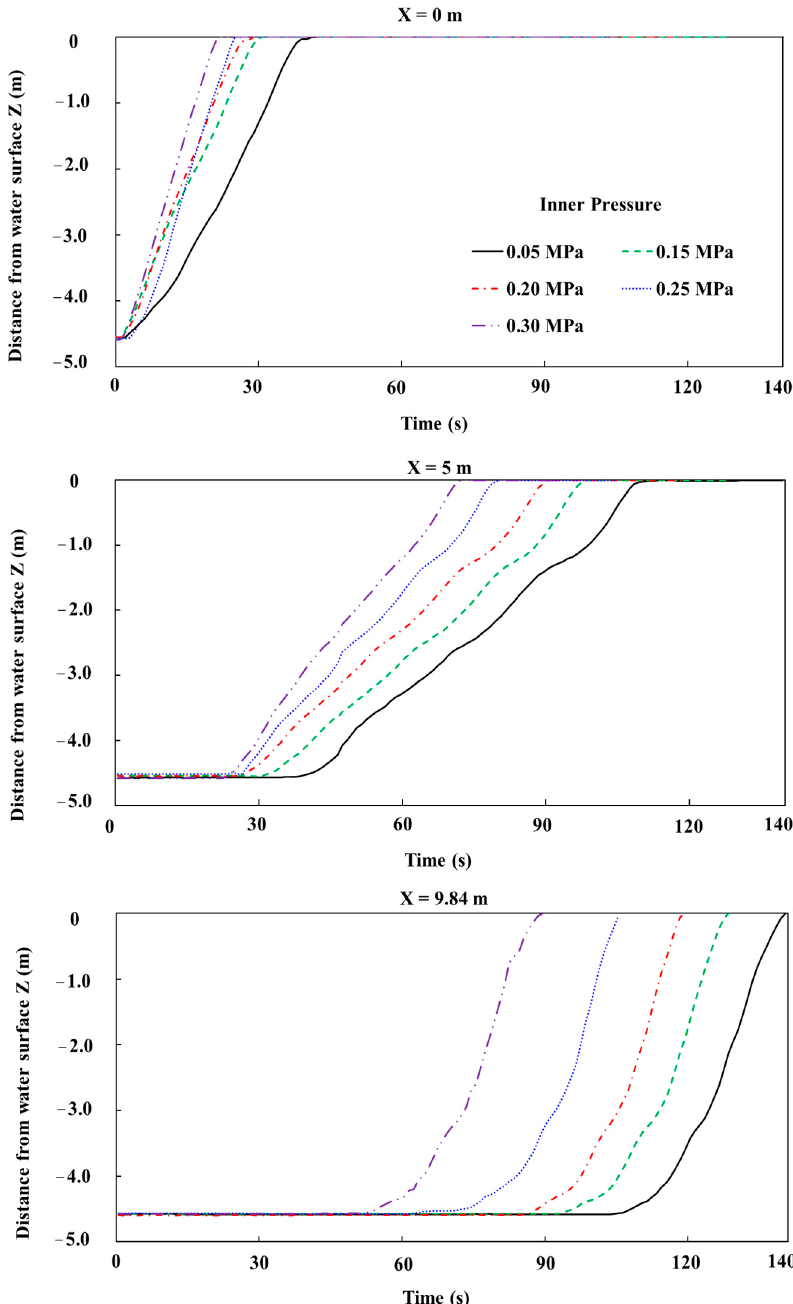
Figure 11. Vertical motion of the air input side (X = 0 m), the middle (X = 5 m), and the rear side (X = 9.84 m) of the hose